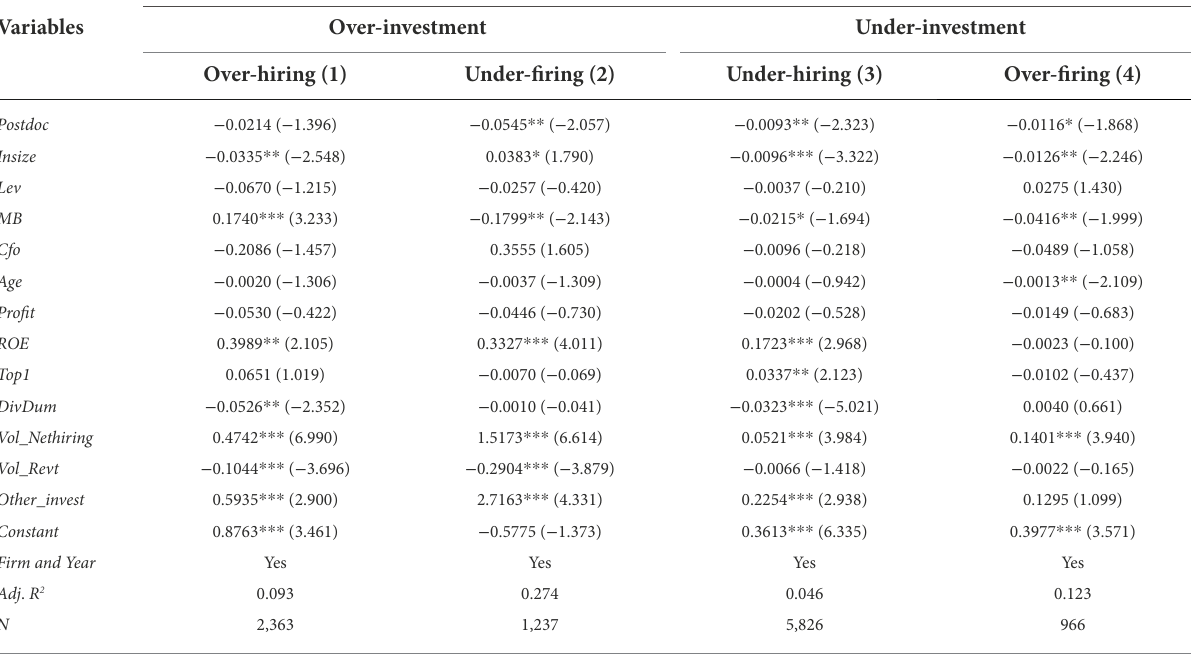
TABLE 5 The effect of postdoctoral workstation on specific types of